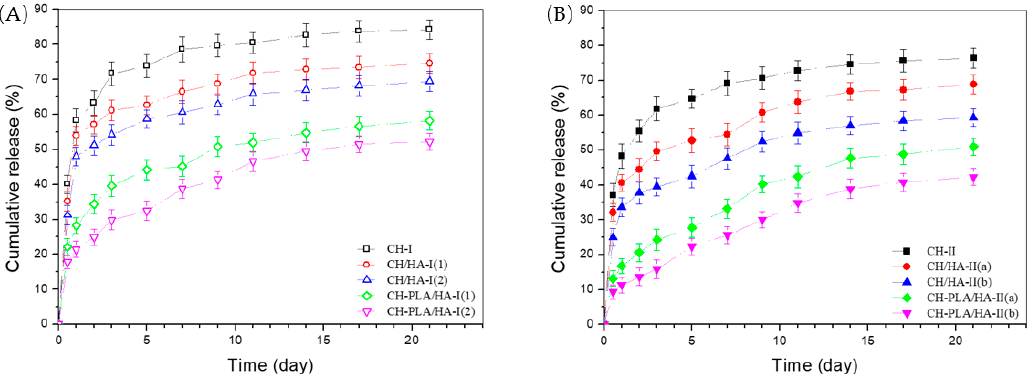
Figure 4. Release profiles of TGF- β 1 from microspheres in set-one ( A ) and set-two ( B ) ( n = 3).